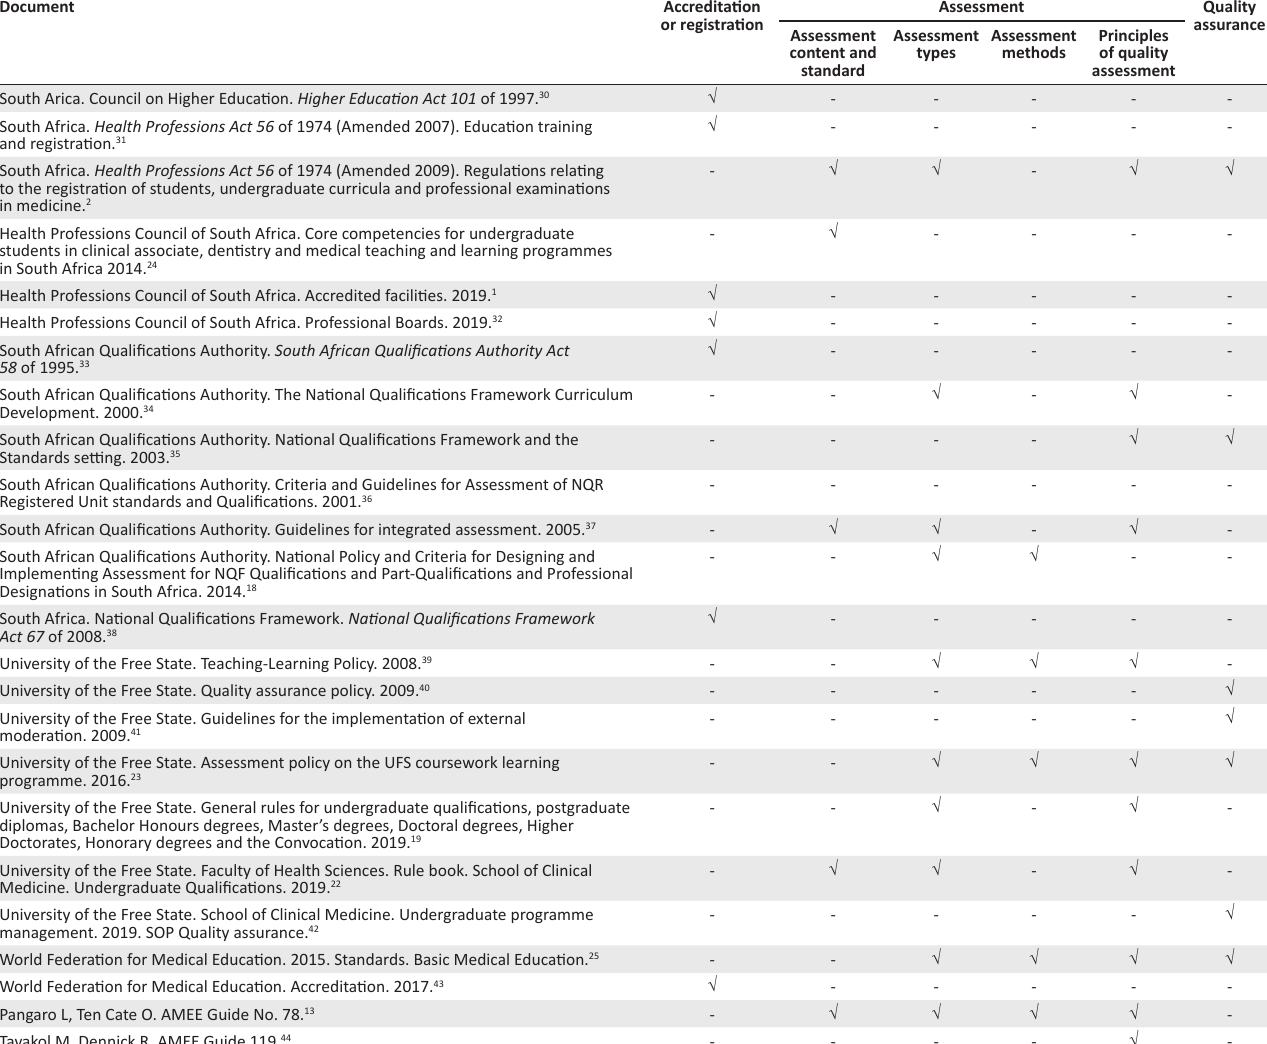
TABLE 1: Primary documents used in document